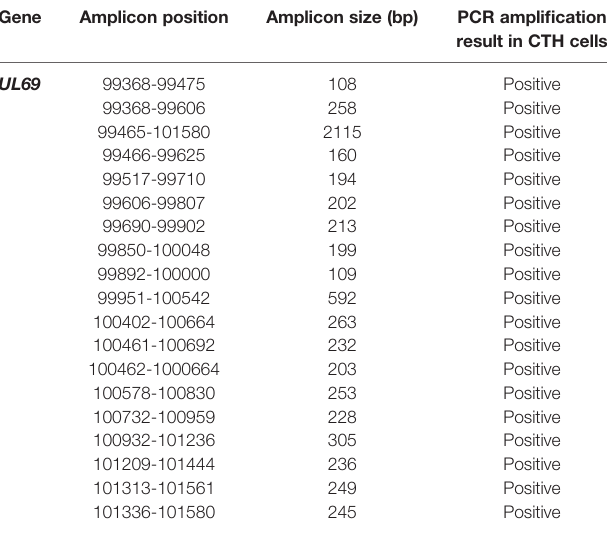
TABLE 1 | Amplicon positions and sizes of the UL69 HCMV-DB gene screened in CTH cells using qualitative and/or quantitative PCR.